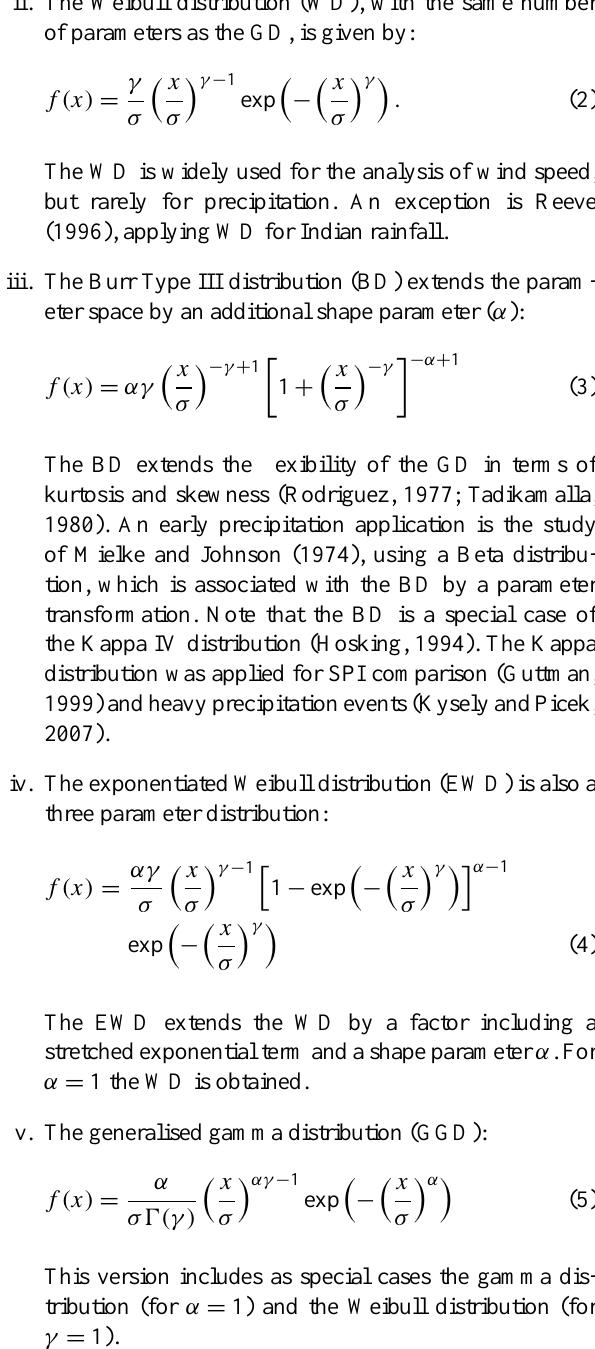
Fig. 3. SPI time series for England Wales precipitation. SPI transformation is calculated with a) GD and b) WD. Wet (dry) SPI extremes are highlighted in blue (red).